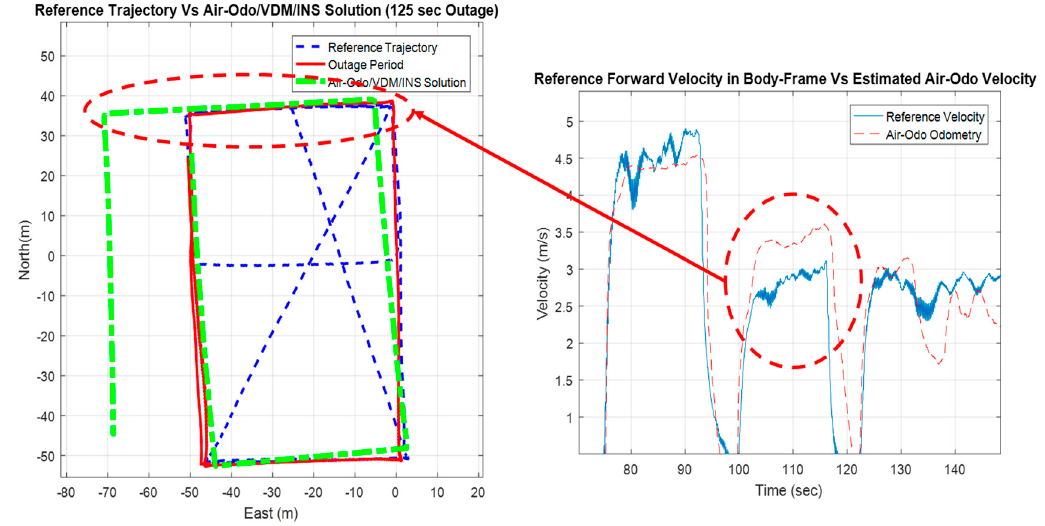
Figure 16. Effect of wind gust on Air-Odo/vehicle dynamic model/INS integration and navigational performance.